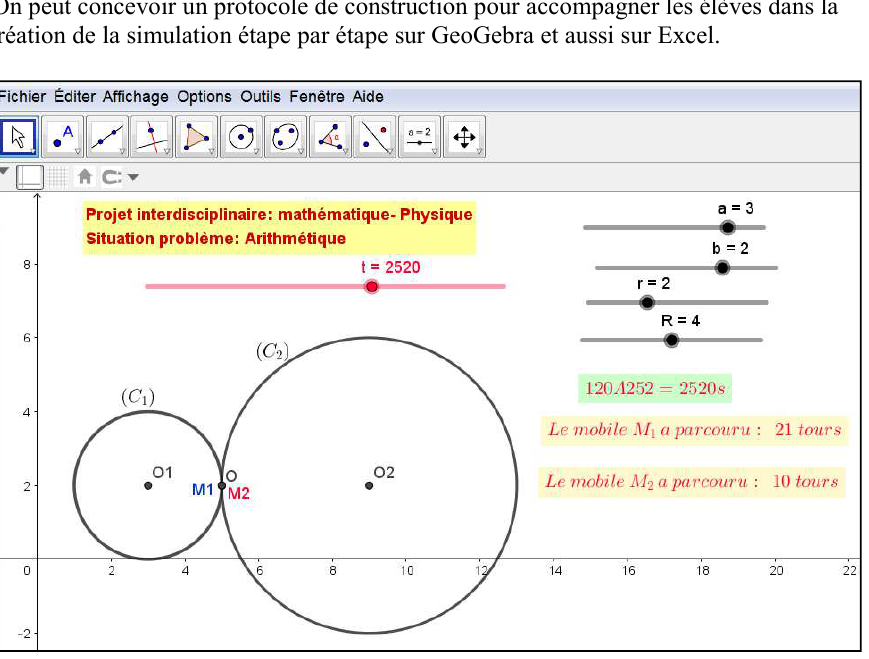
Fig. 8. Simulation du problème en physique par